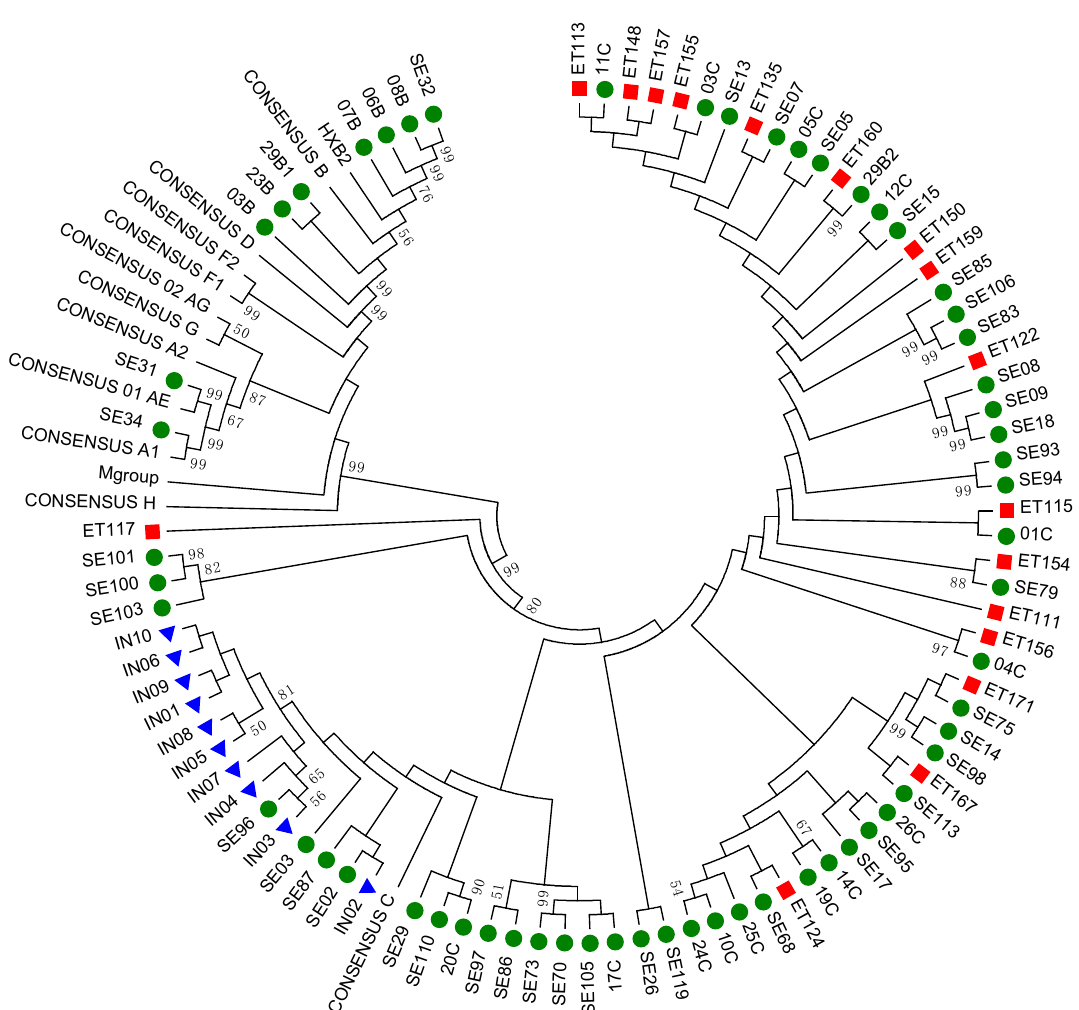
Figure 2. The phylogenetic analysis of the gag-pol sequences. A total of 100 sequences were used in the analysis (87 samples and 13 consensus sequences of gag-vpu from diverse HIV-1 subtypes downloaded from HIVdb). Green circles represent the Swedish cohort ( n = 60), blue triangles represent the Indian cohort ( n = 10), and red squares represent the Ethiopian cohort ( n = 17). The reference sequences of gag-pol from various genetic subtypes—A1, A2, B, C, D, F1, F2, G, H, AE, and AG—were downloaded from the Los Alamos HIV database. After gap-stripping, there were a total of 3096 nucleic acid positions in the final dataset. The bootstrap consensus tree inferred from 1000 replicates is taken to represent the evolutionary history of the taxa analyzed. The tree was drawn to scale, with branch lengths in the same units as those of the evolutionary distances used to infer the phylogenetic tree. The evolutionary distances were computed using the maximum composite likelihood method and are in the units of the number of base substitutions per site.